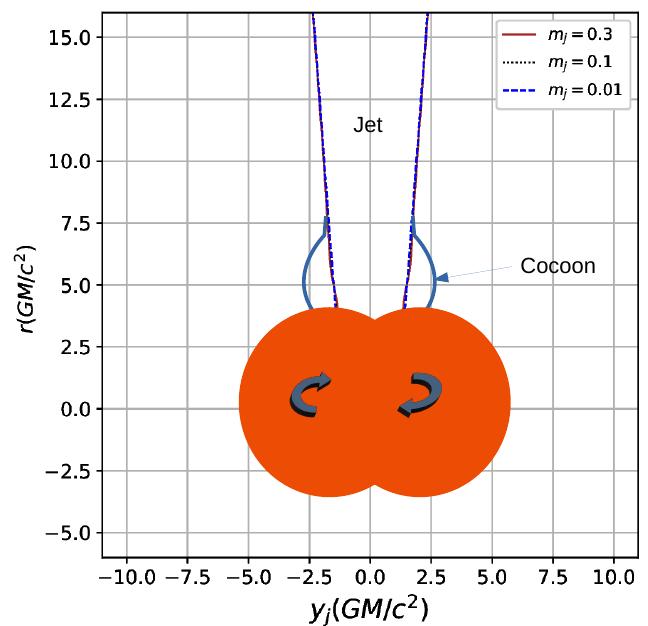
Figure 1. The cross section of the jet above stellar surface for various values of collimation parameters m = 0.01 (solid red), 0.1 (dotted black) and 0.3 (dashed blue). The orange region is the merger where the two compact stars merge. The cocoon shapes the jet geometry and collimates it above the surface of the merger. The lengths are shown in units GM / c 2 or 0.5 r g .